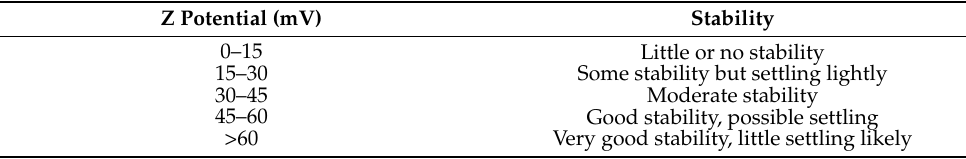
Table 11. Nanofluid stability classification regarding Z